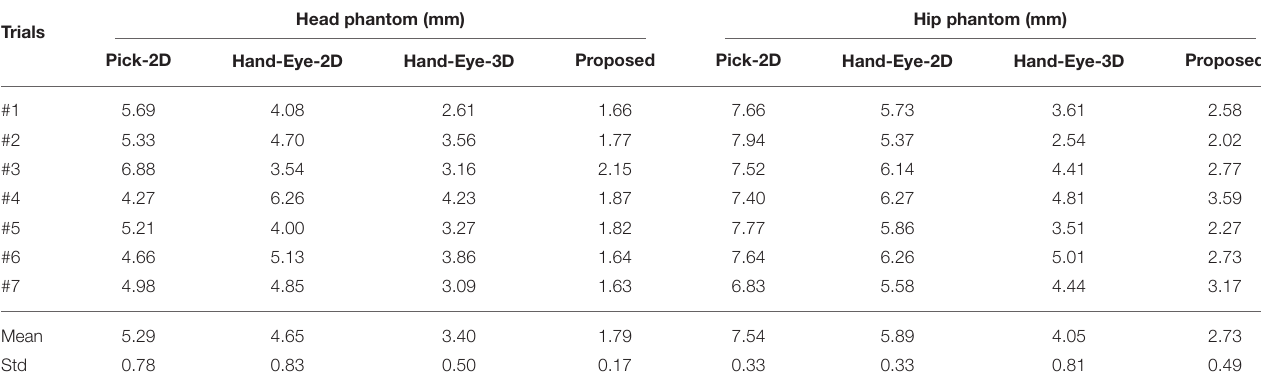
TABLE 2 | TRE values obtained by different methods. Trials